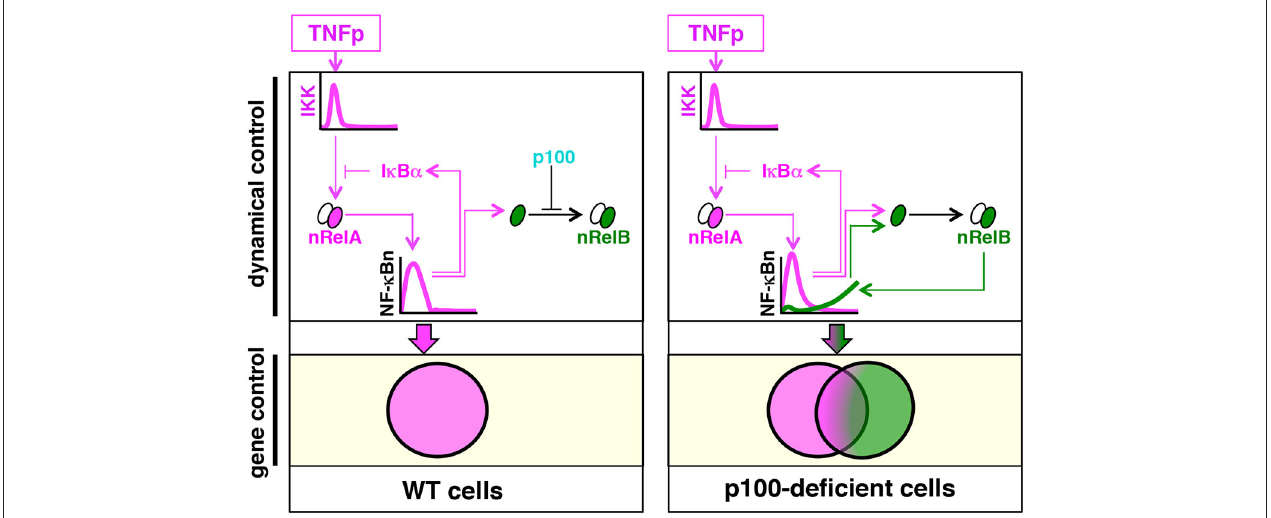
FIGURE 9 | The proposed model explaining the role of p100 in the dynamical control and the gene expression of specificity of TNF-induced NF- κ B signaling. Brief TNF stimulation elicits transient NF- κ B activity composed of RelA:p50 heterodimers, which mediate the expression of immune response genes. An absence of p100 triggers a late RelB:p50 NF- κ B activity in response to TNF that induces also the expressions of genes involved in metabolic and cellular differentiation